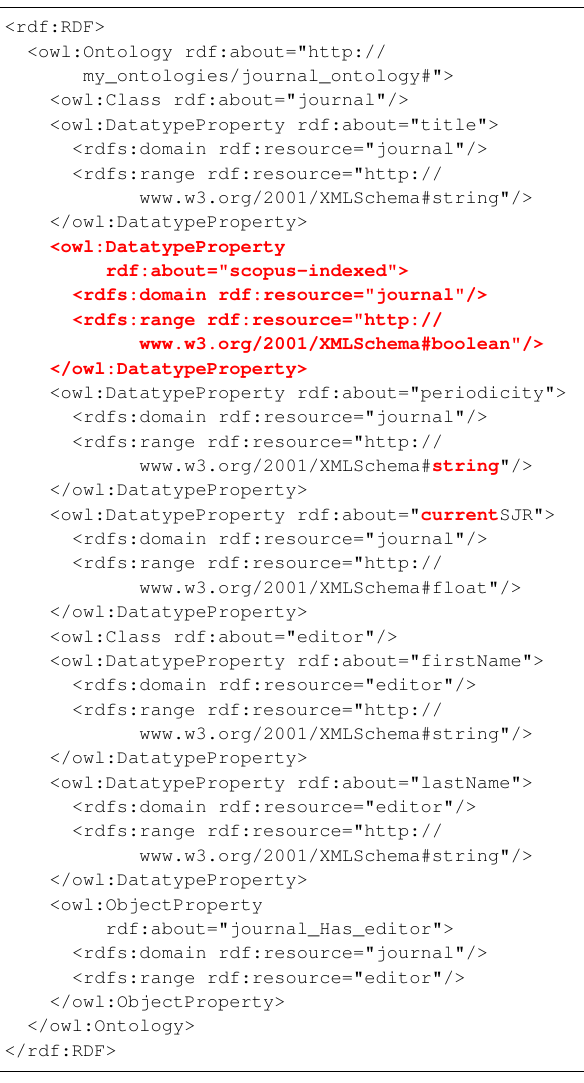
Fig. 12 The generated OWL 2 ontology of journals (“JournalsOntology V2.owl”) on June 13, 2021. databases of the online social networks, like Facebook, Google+, YouTube, and